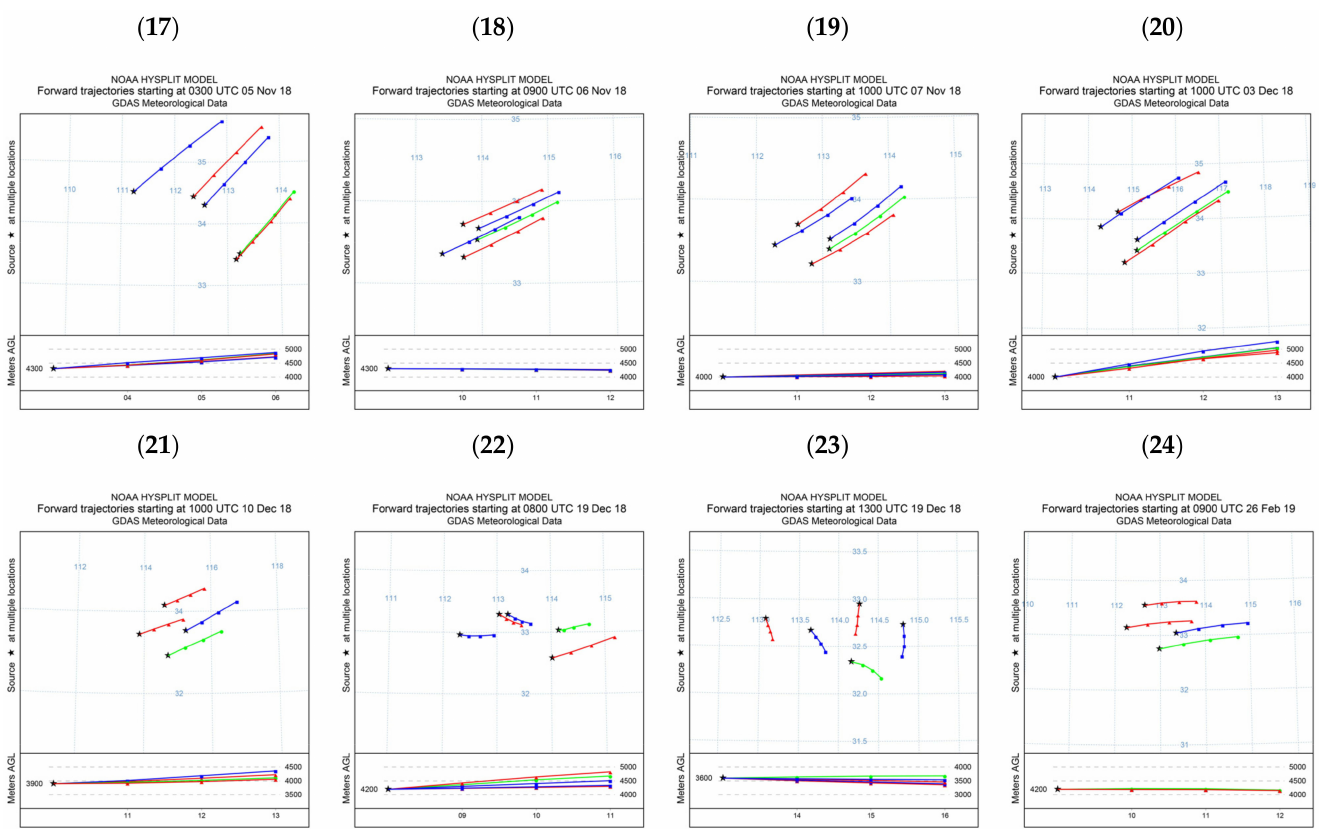
Figure 3. The transmission of boundary points of affected areas within 3 h after seeding for 24 aircraft precipitation enhancement operations simulated by HYSPLIT model ( 1 – 24 ). Note: The upper part of each graph represents the horizontal transport path of the seeding point, the horizontal and vertical coordinates are longitude and latitude, respectively. The lower part represents the vertical transmis- sion height of the seeding point, the horizontal and vertical coordinates are time (h) and altitude (m), respectively. Red, blue, and green lines indicate the transport paths of different seeding points.